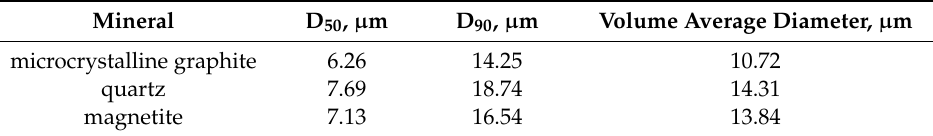
Figure 2. X-ray diffractometer (XRD) patterns of quartz and microcrystalline graphite. Figure 2. X-ray di ff ractometer (XRD) patterns of quartz and microcrystalline graphite. Table 4. Grain size distribution of di ff erent minerals. Table 4. Grain size distribution of different minerals.